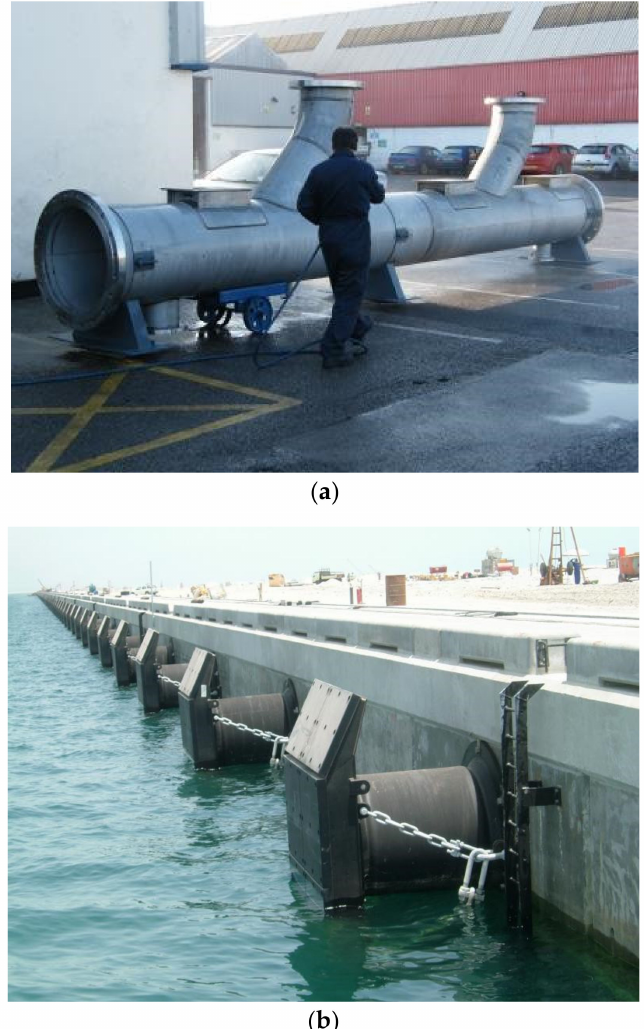
Figure 5. Applications for superduplex stainless steel in seawater. ( a ) Seawater manifold ( b ) Fasteners for rubber dock fenders.